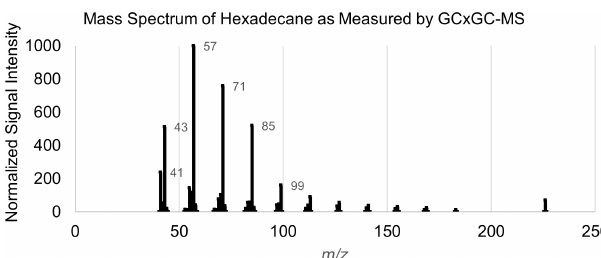
Figure A1. Mass spectrum of hexadecane, as measured by GCxGC- MS and featurized in Table